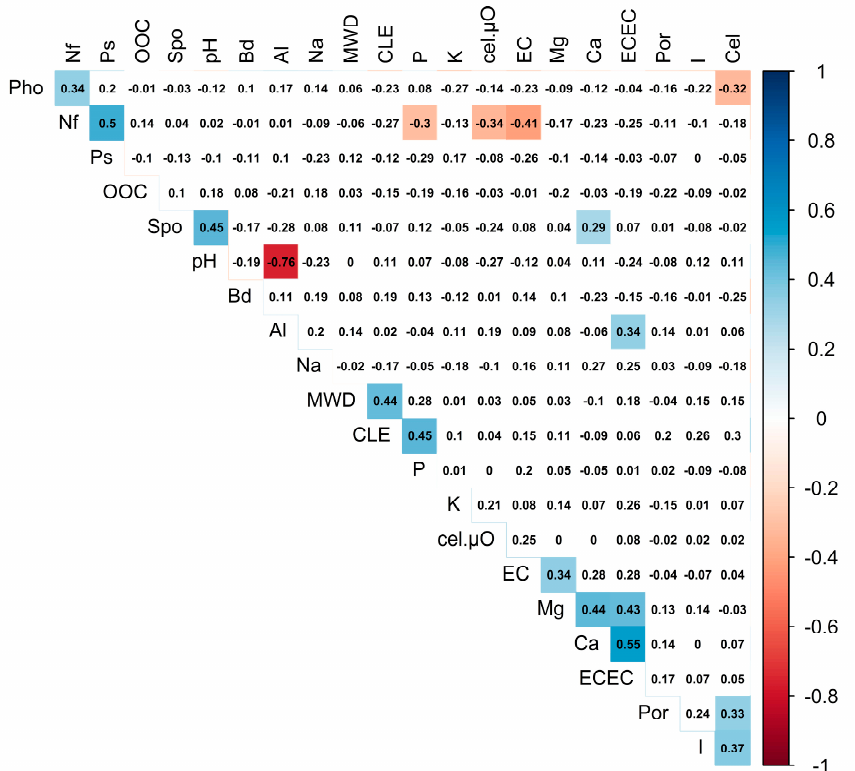
Figure 4. Correlogram reporting the relationship between physical, chemical, and biological variables measured in the rhizospheric soil of olive trees. Colored cells indicate a significant correlation at a confidence level of 95%. Blue cells indicate a positive correlation and red cells indicate a negative correlation. The value inside each cell corresponds to Kendall ( r τ ) correlation coefficient with Bonferroni-adjusted p -values.